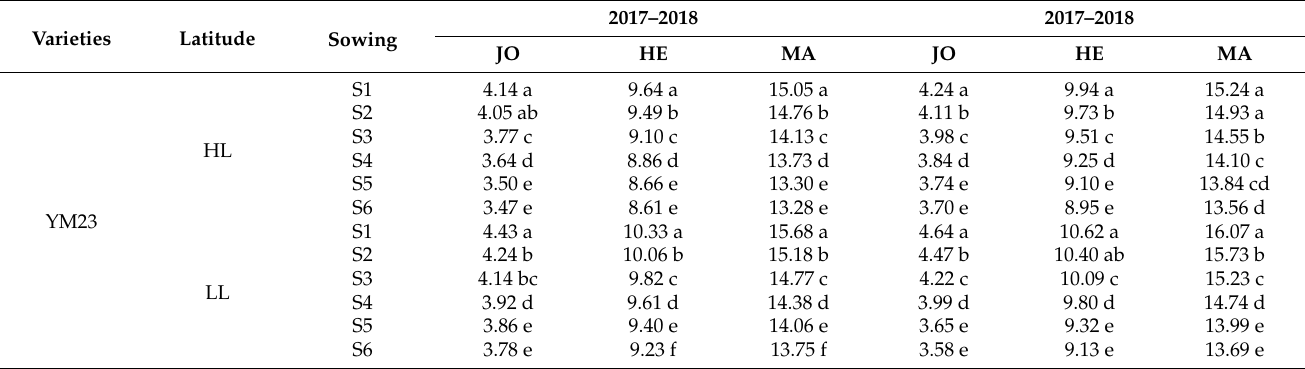
Table 7. Effects of different temperature and radiation on dry matter